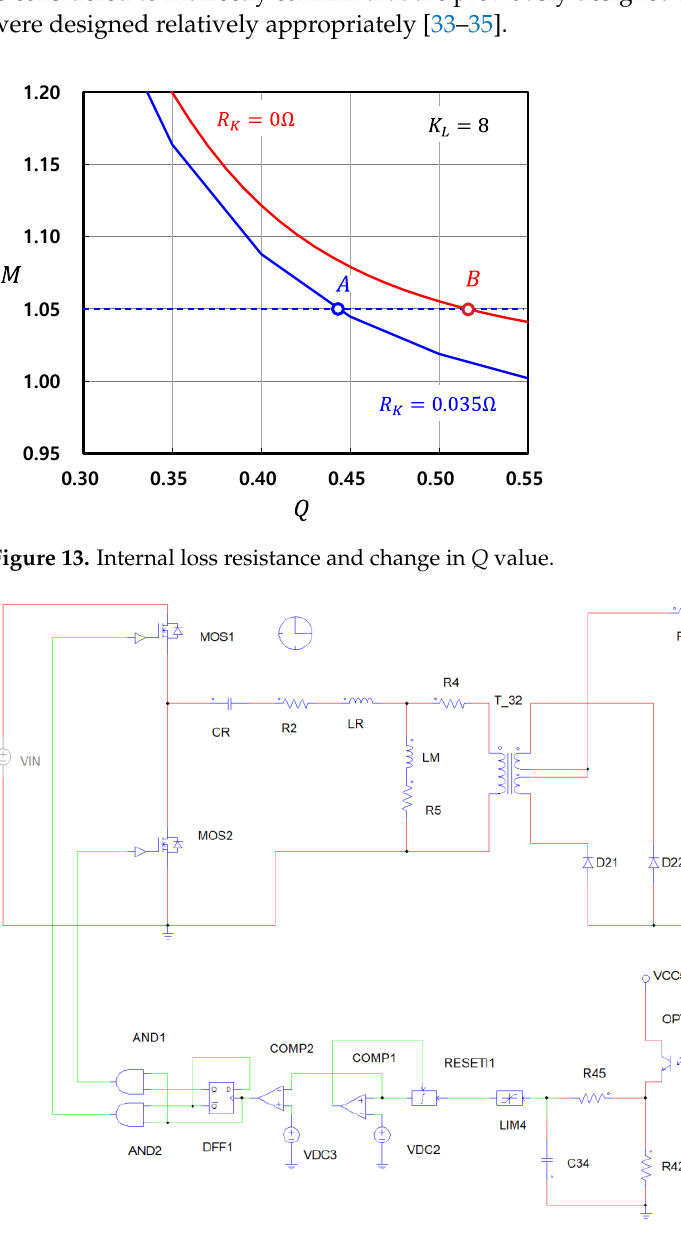
( a ) ( b ) Figure 15. Steady-state waveform result of half-bridge LLC resonant converter with PSIM simula- tion: ( a ) At low load power; and ( b ) at full load power. 4. Experimental Results In order to verify the design result of the LLC resonant converter in the previous section, an experimental circuit was constructed and its characteristics were analyzed. Ta- ble 4 shows the models and electrical specifications of the main components used in the experimental circuit. In Figure 1 6, Vishay’s 650 V class MOSFET was used for the main switch and the gate on- resistance was 39 mΩ. Six resonant capacitors were used in parallel to increase the current rating, and a ferrite core (PQ3552 model) was used for the trans- former. The rectifying diode on the secondary side of the transformer applied a synchro- nous rectifier circuit to reduce the rectification loss, and the on-resistance of the rectifier switch was 5.1 mΩ. Fig ure 17 provides a photograph of the experimental configuration, which shows the experimental circuit and measuring instruments used for the test. The Time (s) Time (s)